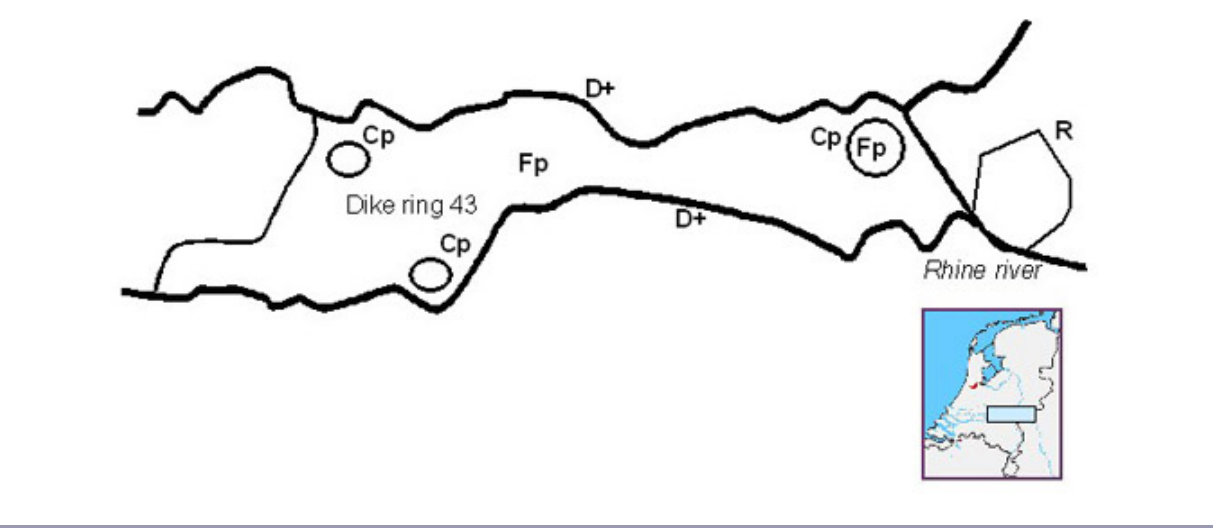
Fig. 4. Schematic overview of the possible flood protection investments in dike-ring area 43 in the central part of the Netherlands. The four possible investments are: Asset D+, main dike reinforcement; Asset Cp, compartments around urban areas; Asset Fp, flood protection residences; Asset R, Upstream retention